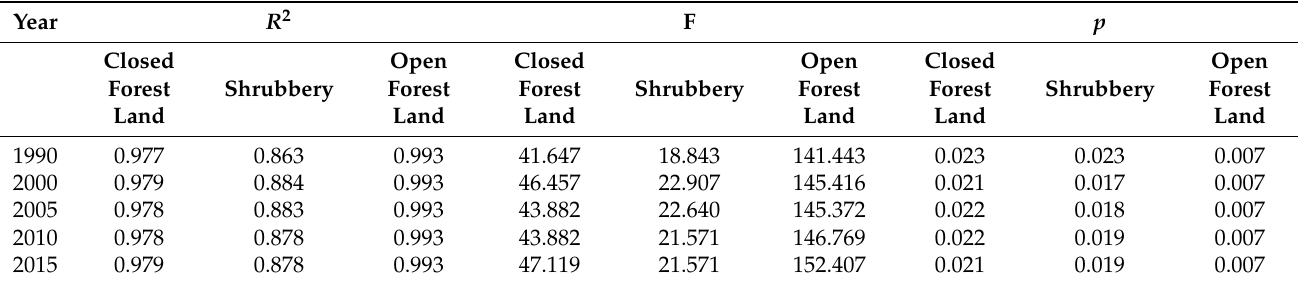
Table 1. Regression analysis on altitude element and distribution of three types of forest landscape. R 2